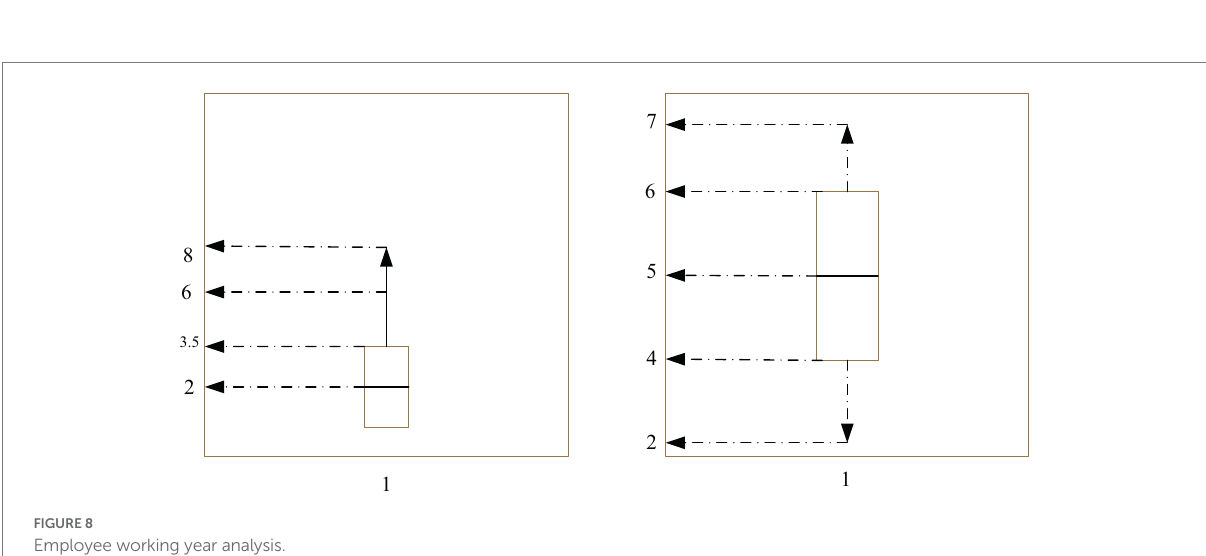
FIGURE 8 Employee working year